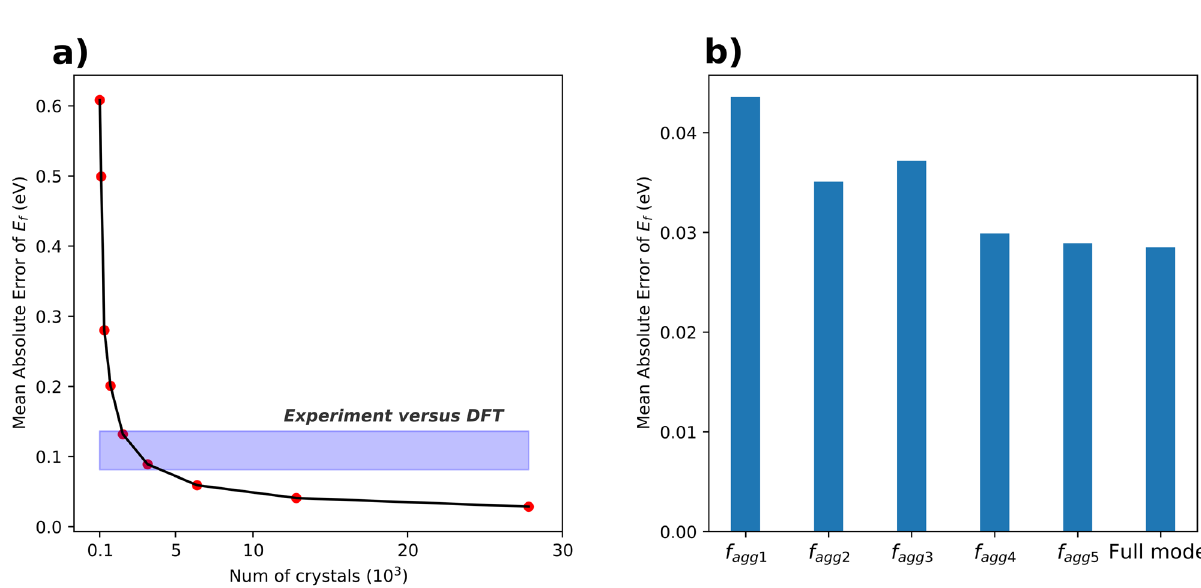
Fig. 5 Experiments on 9274 DFT data in Material Project. a Different volume of training data versus the MAE of E f . b The MAE of E f on 6 different aggregation